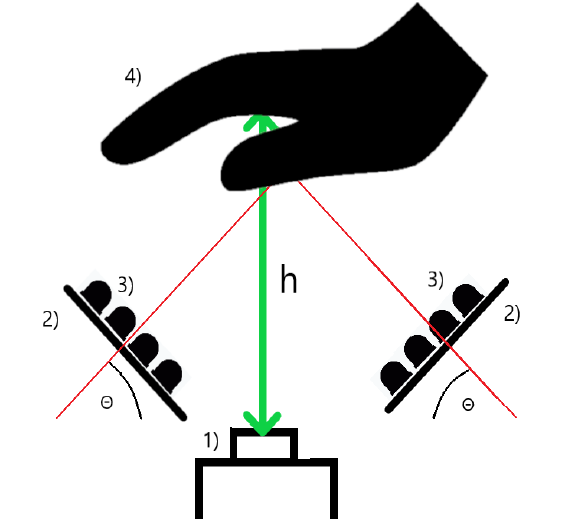
Figure 2. Overview of the system, where (1) is the Charge Coupled Device (CCD) sensor, (2) is the illuminators, (3) is a mix of the NIR and UV diodes, (4) is the hand of the user, ( θ ) is the 45 degrees angle, and (h) is the distance between the users’ hand and the sensor